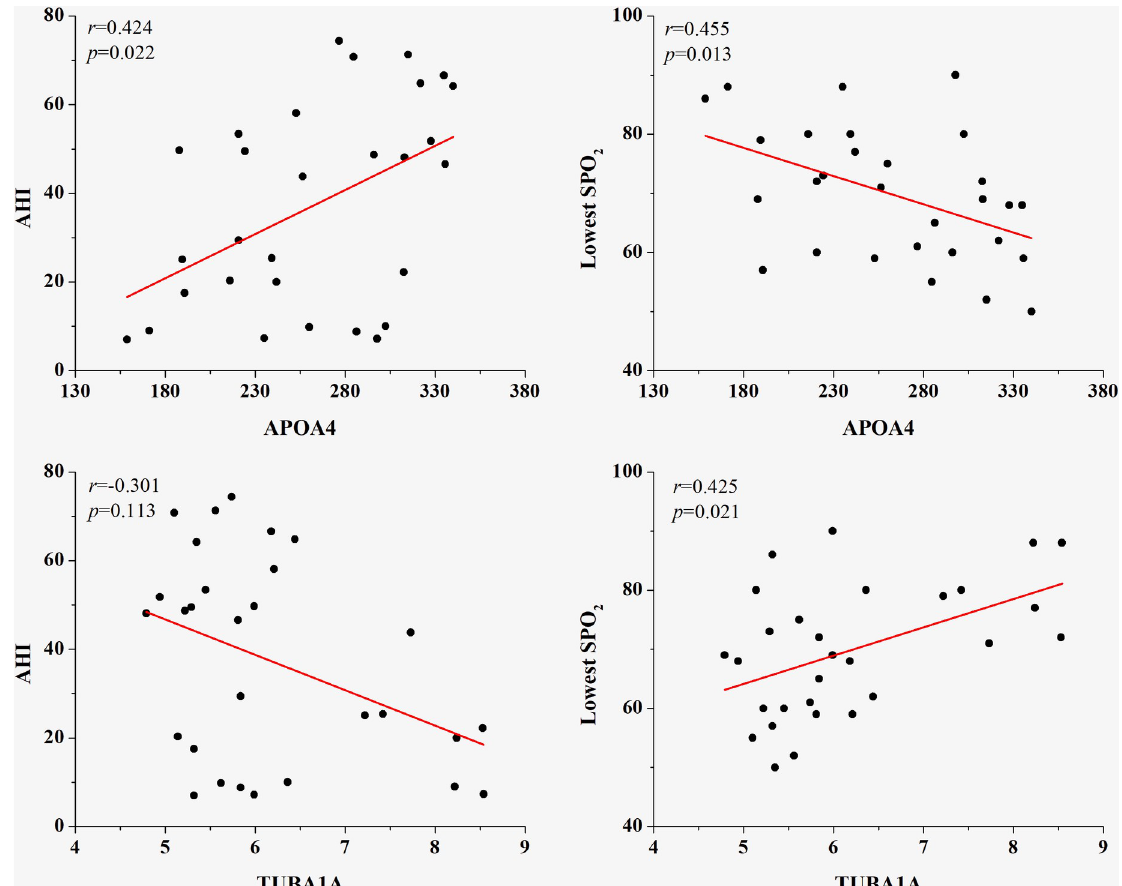
Fig 5. The relation between four differentially expressed proteins and polysomnography parameters.